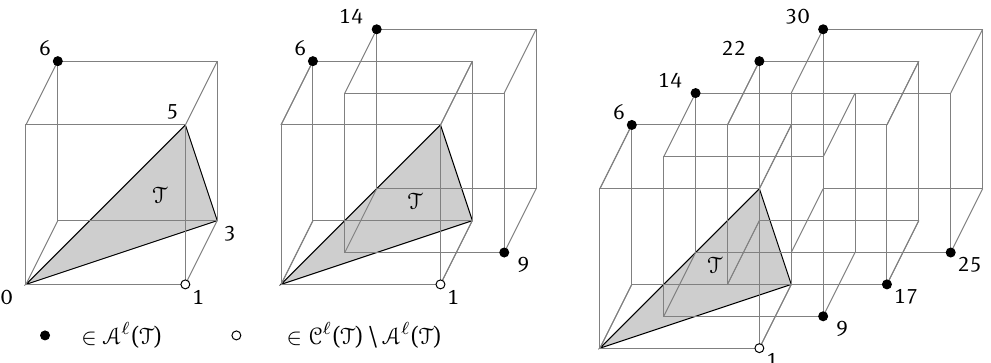
Figure 14: Impression of the structure of the sets A (cid:96) ( T ) and C (cid:96) ( T ) for increasing values of (cid:96) . The white vertex is not in A (cid:96) ( T ) but the ones “orthogonally above” it, are in A (cid:96) ( T )